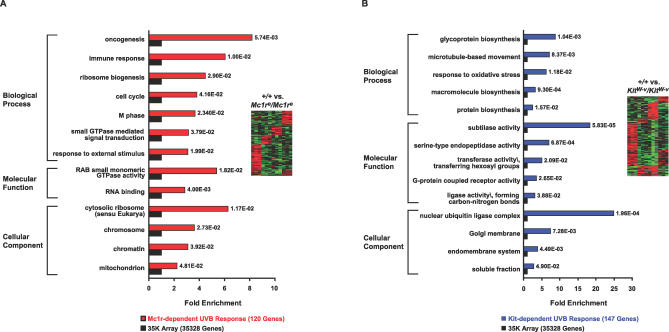
Over-Representation Analysis of Functional GO Terms for Mc1r- and Kit-Dependent UVB-Responsive Genes in the Basal Epidermis of P2.5 MiceGO terms, using EASE software [48], were mapped to (A) 120 Mc1r-dependent UVB-responsive genes (red bars) and (B) 147 Kit-dependent UVB-responsive genes (blue bars). GO terms that were significantly enriched (p = 0.05), by 2-fold, relative to all of the assayed genes on the 35,000 array (35,328 genes) (black bars) and that contained at least three gene hits, are displayed. GO terms are ranked, within high level GO branches, by fold-enrichment relative to the 35,000 array. A thumbnail image provides a reference for each of the analyzed UVB response classes.